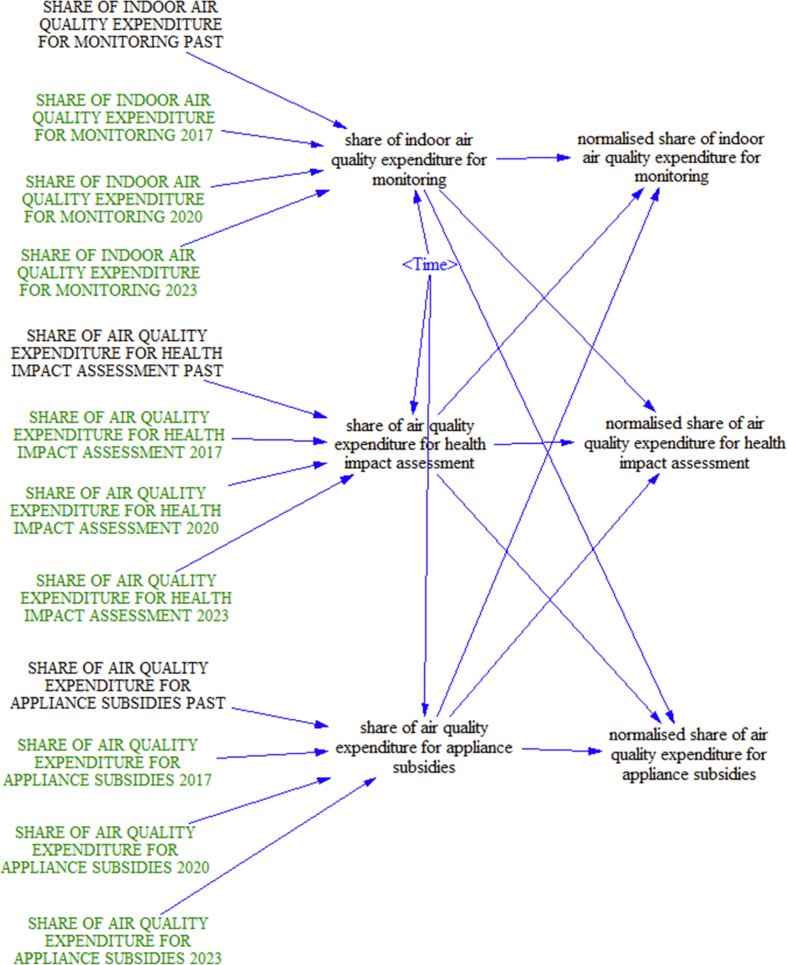
Division of funds.